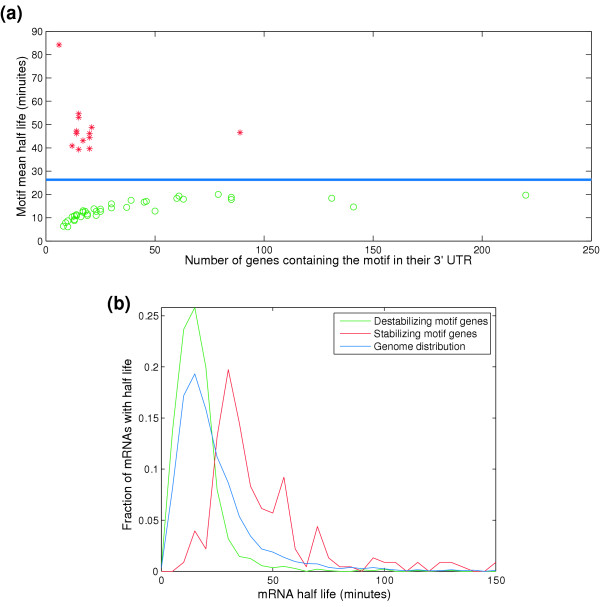
mRNA half life distributions. (a) The mean half-life versus gene target set size of 50 stabilization-associated 3' UTR motifs. The genome mean is indicated by a blue line at 26.3 mins. Each stabilizing motif is marked with a red asterisk, and each de-stabilizing motif is marked by a green circle. Motif M1, which mediates a mean half-life of 16 mins for a target set of 641 genes, is not displayed in the figure. (b) Half-life distribution of the target gene sets of all destabilizing motifs (green), of target gene sets of all stabilizing motifs (red), and of all genes (blue).